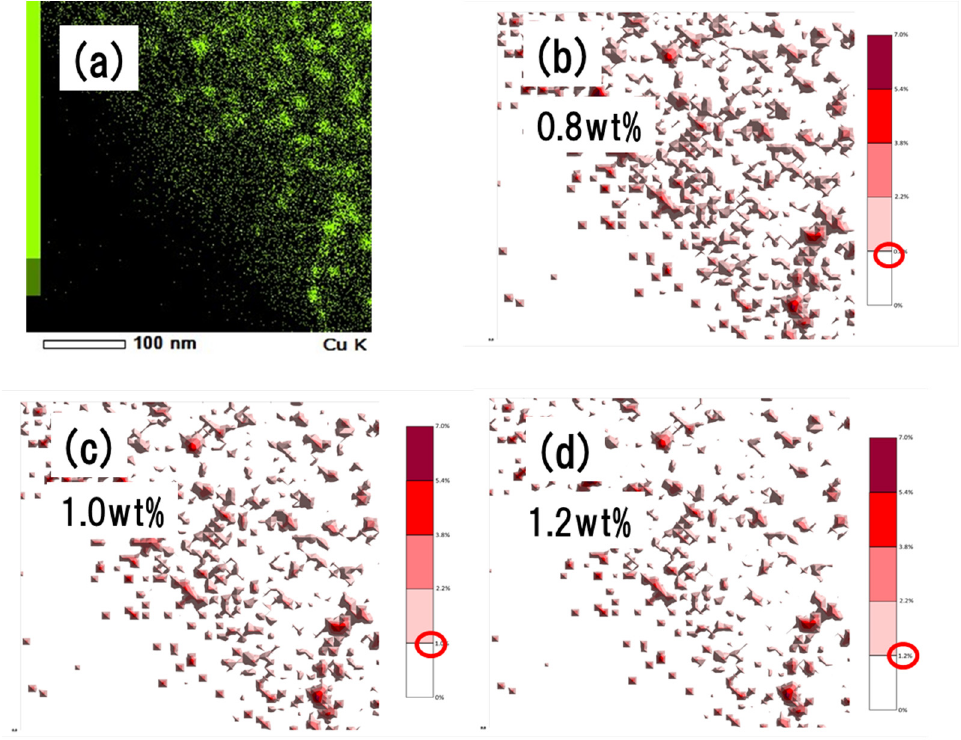
Figure 7. Qualitative analysis of Cu wt% of the sample to show that the Cu cluster threshold values were introduced: ( a ) Cu atom map, ( b ) 0.8 wt%, ( c ) 1.0 wt%, and ( d ) 1.2 wt%. Threshold values are shown by red circles in the figure.